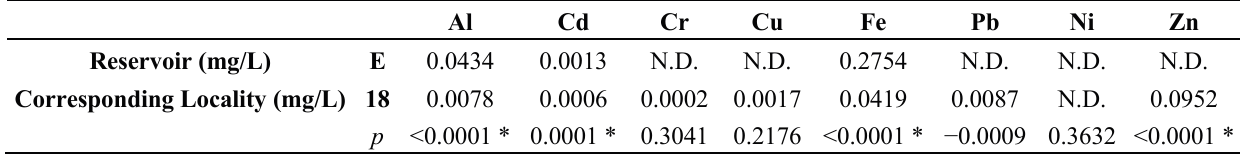
Table A5. Statistical variation between Reservoir E and its feeding Locality 18.